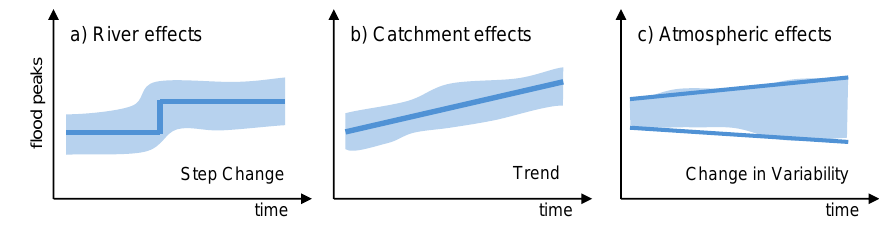
Figure 2. Typical types of changes in flood peaks over decades or centuries as caused by (a) construction/removal of hydraulic structures, (b) gradual land use change, (c) increasing variability of extreme rainfall. Shaded areas represent intra-decadal